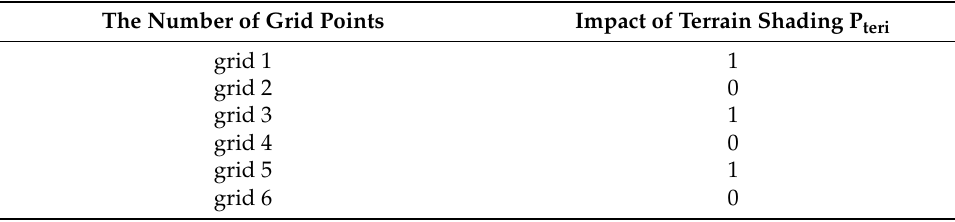
Figure 5. Elevation value point coverage criterion in the direction of node perception. Table 1. The impact of terrain shading on corresponding grid